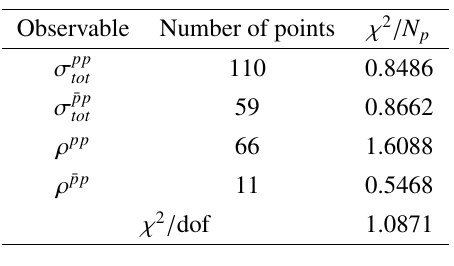
Table 1. Number of experimental points N p and χ 2 / N p for σ tot and ρ in the fit with FMO